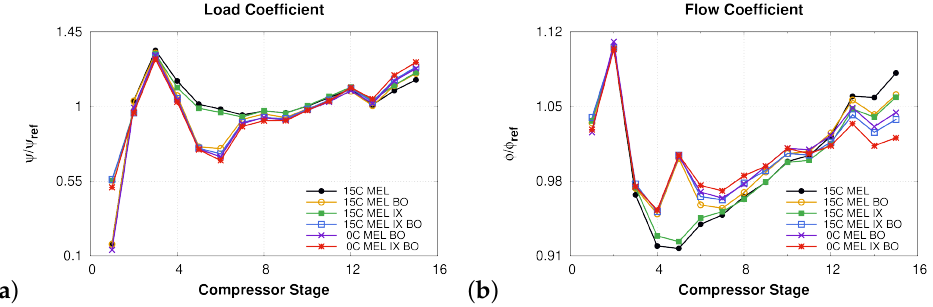
Figure 10. Test matrix stage flow coefficient ( a ) and stage load coefficient ( b ) for the six configura- tions analyzed.